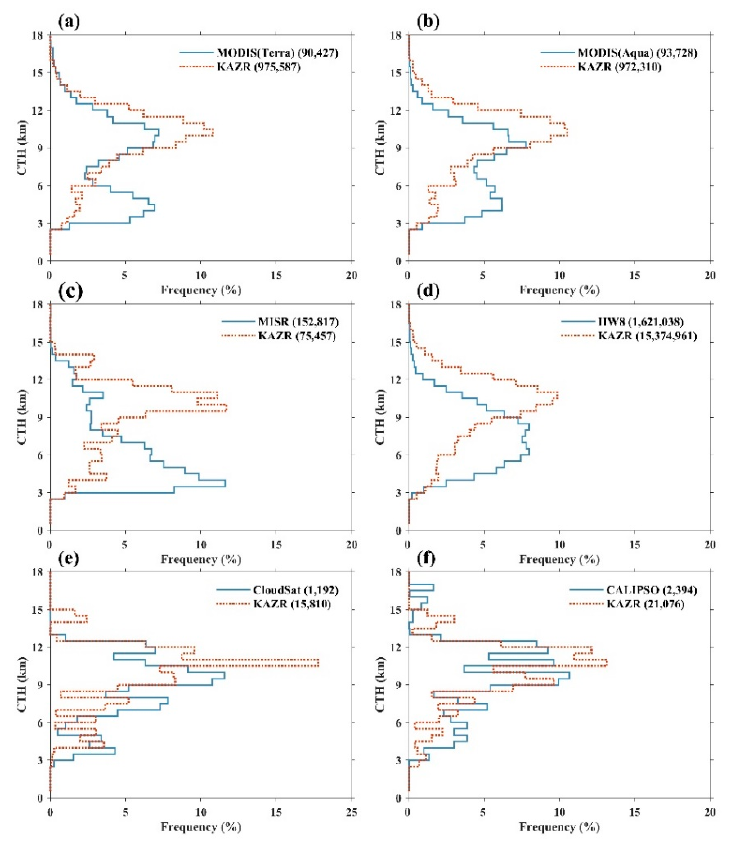
Figure 7. Same as Figure 3 but for overlapping clouds. The seasonal variations of CTH frequency for overlapping clouds are shown in Figure 8. Compared with the distribution of KAZR CTH, the significant differences occur in winter for MODIS and HW8, and summer for MISR, which are similar to the results in Figure 4a–d. However, the height differences of CTH peak frequency between passive satellite sensors and KAZR in overlapping clouds have a seasonal variation. The peak height of CTH for high clouds from MODIS is slightly lower than that from the KAZR, and their distance is about 3 km (Figure 8(a2,b2)). The HW8-retrieved CTH concentrates at the altitude of 6–9 km, which is lower than the peak frequency height of KAZR-retrieved CTH, and the distance reaches up to 6 km (Figure 8(d2)). The peak frequency height of MISR CTH is around 4 km, which is significantly lower than that of KAZR CTH by 9 km (Figure 8(c2)). Therefore, high surface temperature and strong convection in summer